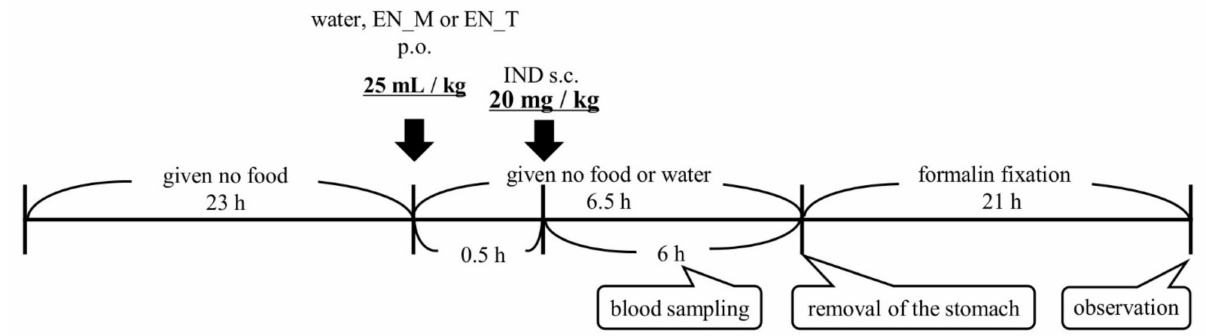
Figure 1. Experimental protocol. IND: indomethacin; EN_M: Mermed ® One; EN_T: Terumeal ® 2.0 α diluted by a factor of 2 with purified water to reduce the caloric content to that of EN_M; p.o.: per os; s.c.: